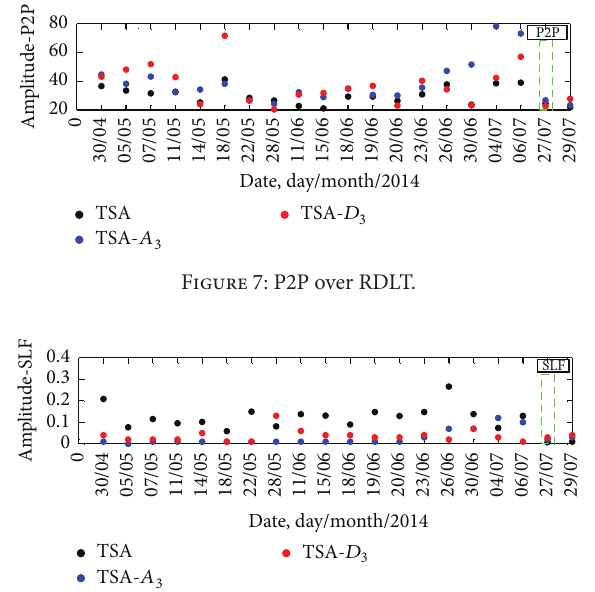
Figure 8: Sideband Level Factor over